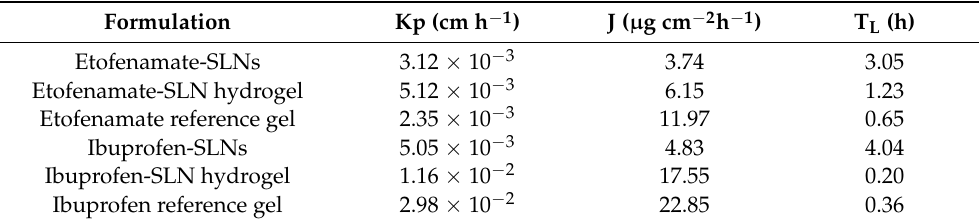
Table 3. Values of permeability rate constant (Kp), flux (J), and lag time (T L ) obtained for the permeation of etofenamate and ibuprofen across human